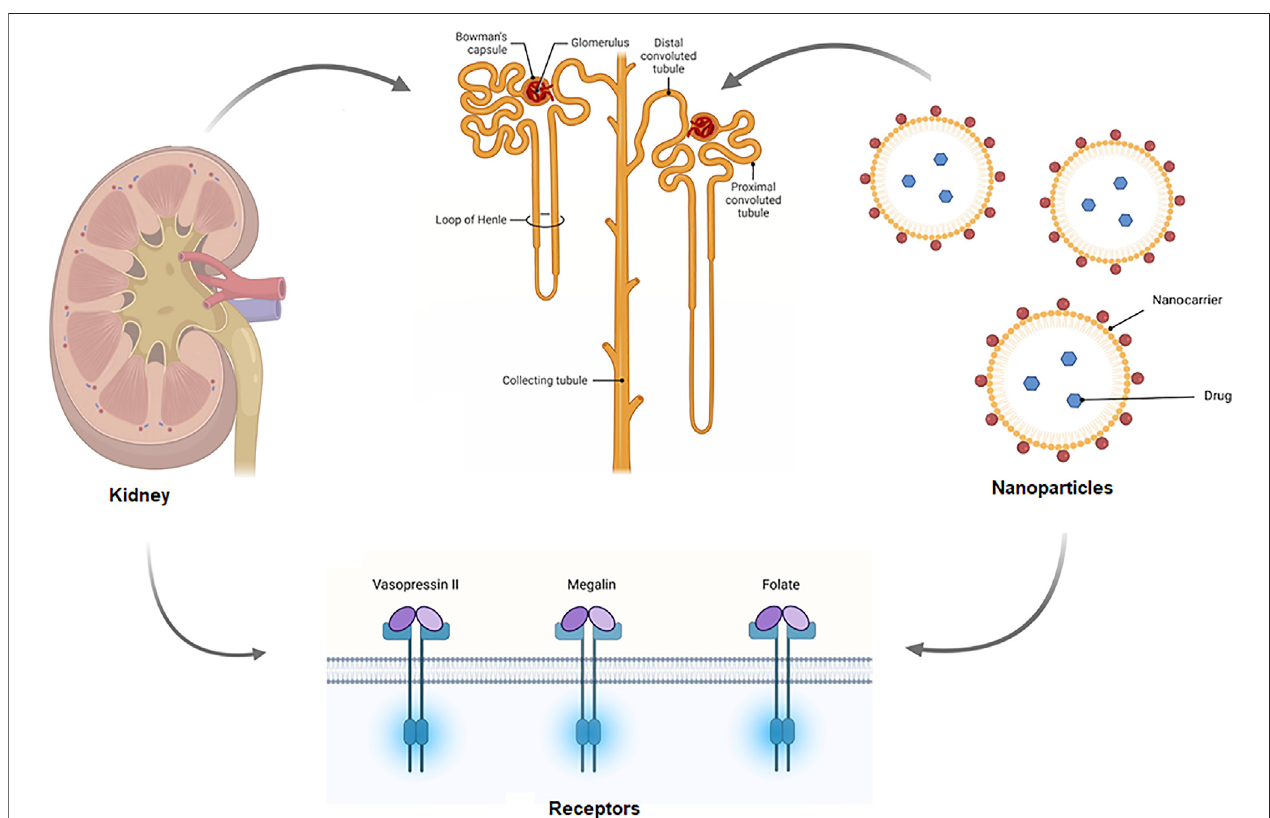
FIGURE 2| Schematic ofthe mechanism of targeted drug deliveryin the kidney. Drug carryingnanoparticles enter the kidney via the renal artery and are carried to the afferent arteriole, where they remain in the bloodstream or are subjected to renal fi ltration from the blood in the glomerular capillaries. Renal componentssuch as the glycocalyx, endothelial cells, and the glomerular basement membrane can be tailored to help select NPs for fi ltration. NPs can interact with podocytes in the Bowman ’ s lumen after fi ltering. The fi ltrates NPs are carried to the proximal tubule, where they interact with proximal epithelial cells and might be reabsorbed.